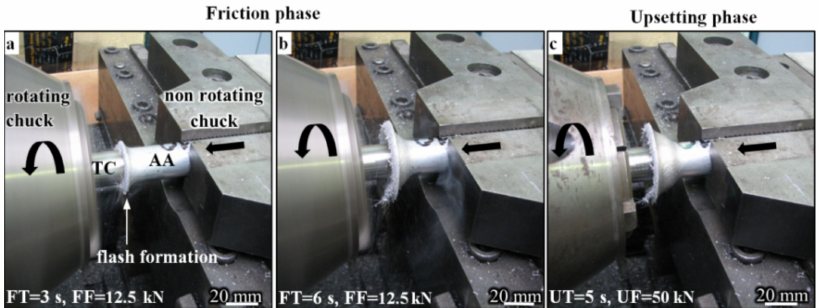
Figure 2. Continuous drive-friction welding process: ( a , b ) friction phase, ( c ) upsetting